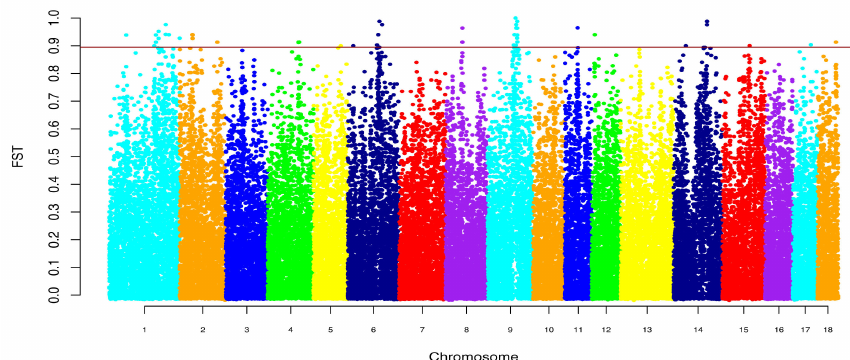
Figure 1. Genomic distribution of F ST values estimated between the LV and DU breeds. Values for the X -axis are pig autosomes (the breadth of autosomes corresponds to their length); and those for the Y -axis are F ST values. SNPs were plotted relative to their positions within each autosome. The threshold, which was estimated as the top 0.1% for F ST values, is indicated by a horizontal line. Each chromosome is marked with different